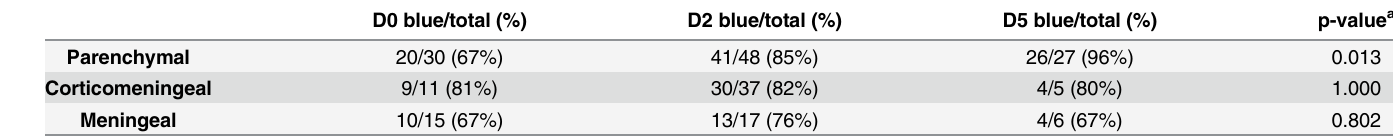
Table 3. Effect of cysticercal location on the association of treatment and disruption of the BBB.